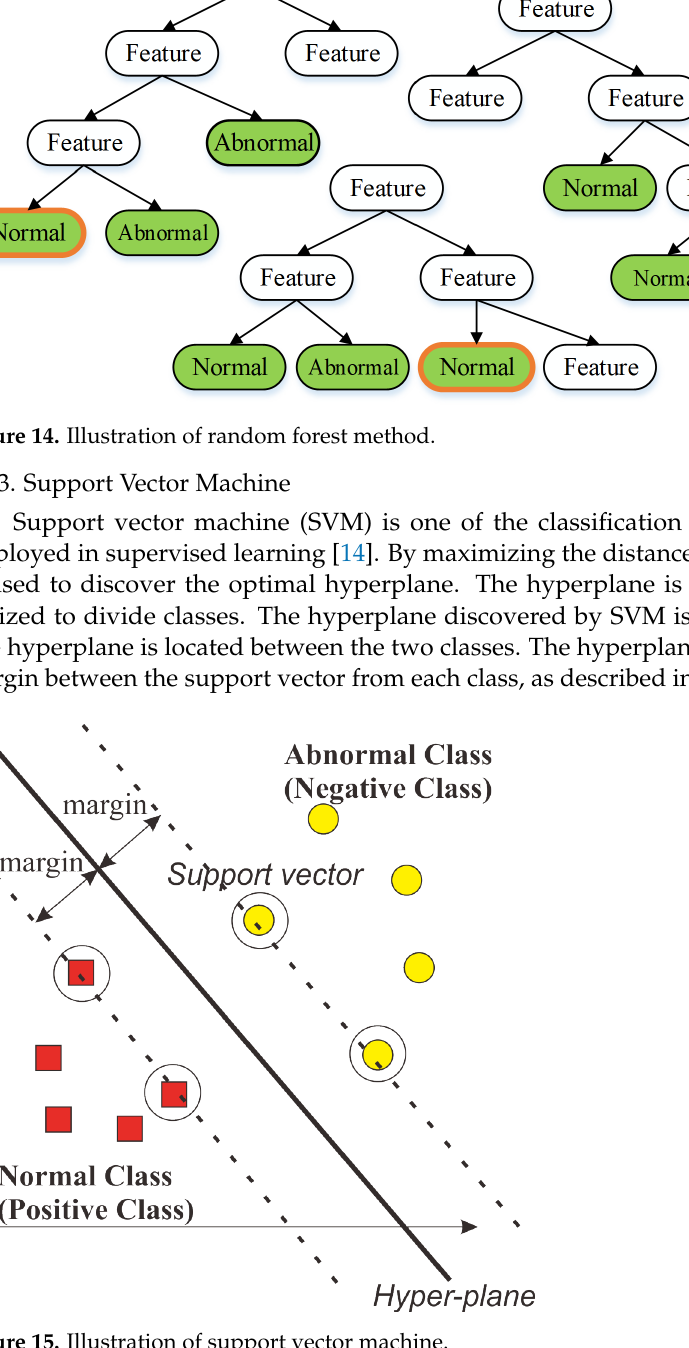
Figure 15. Illustration of support vector